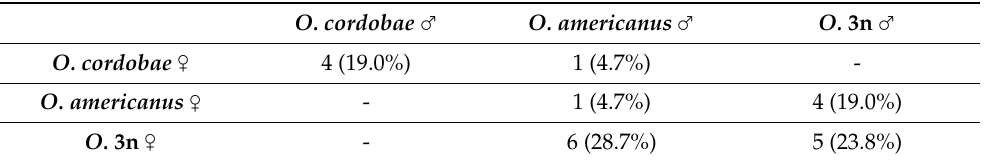
Table 3. Taxonomic composition of amplecting Odontophrynus pairs (N = 21) collected at the La Escondida locality. Ploidy of males was assessed by erythrocyte size and advertisement call features, that of females exclusively by erythrocyte size.